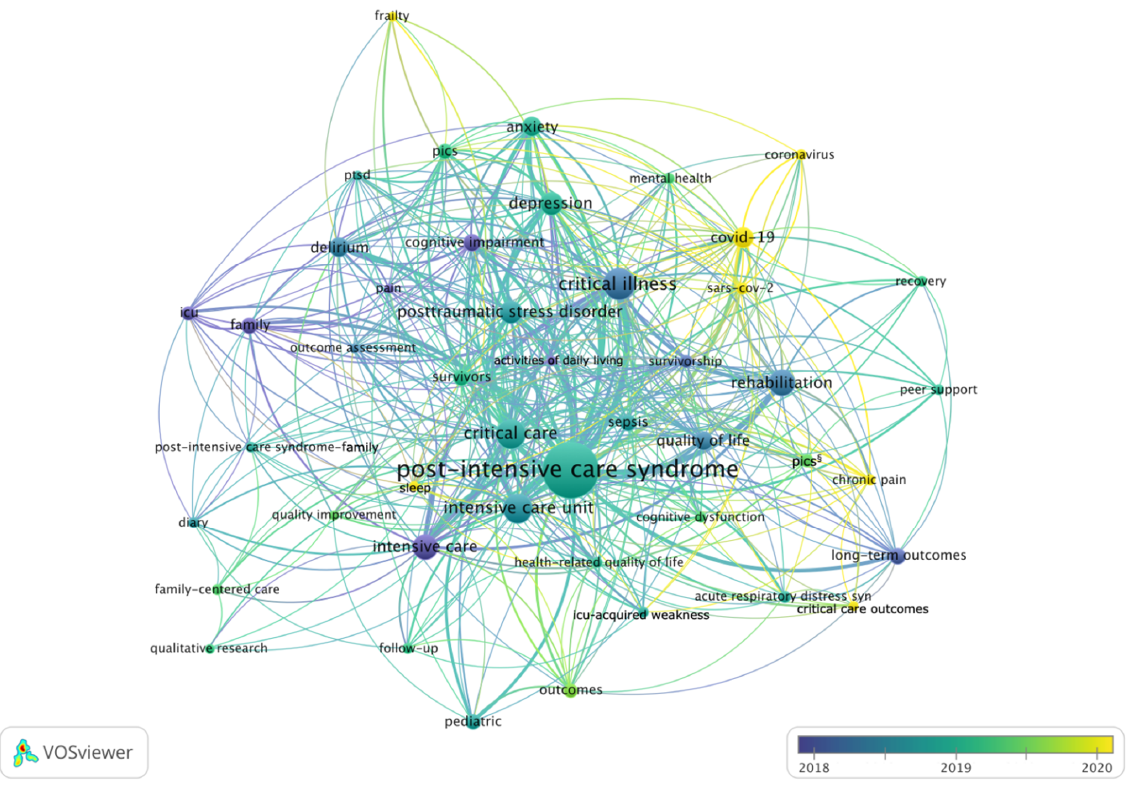
Figure 5. Keyword co-occurrence among articles on post-intensive care syndrome. Lines indicate direct keyword co-occurrences. Thicker lines are indicative for more direct keyword co-occurrences. The further two keywords are apart, the weaker is their relation. Colors indicate the average publi- cation year of articles with the respective keyword. Keywords with at least five publications are shown. § Abbreviation for the keyword ‘post-intensive care syndrome (pics)’. Created using VOSviewer.